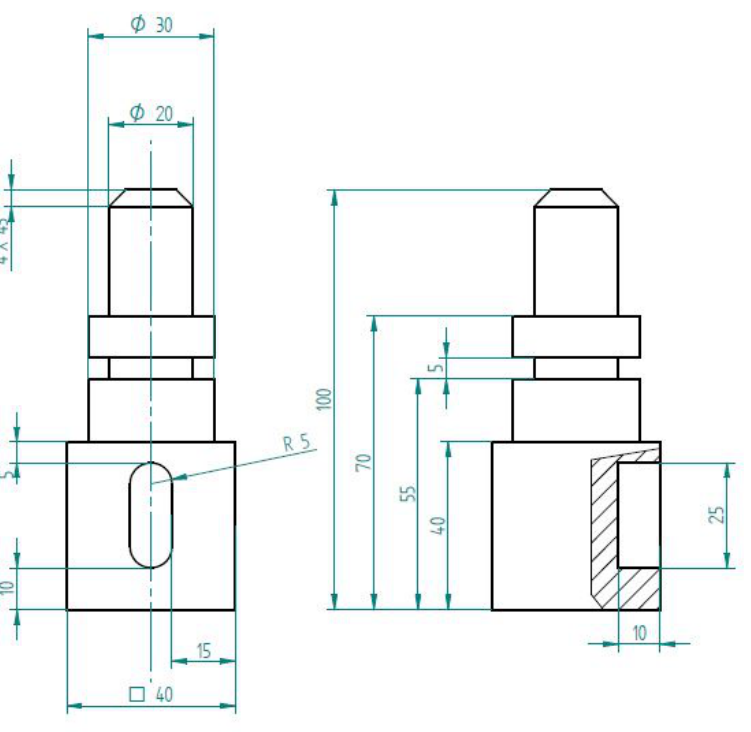
Figure 7. The designed product for demonstration